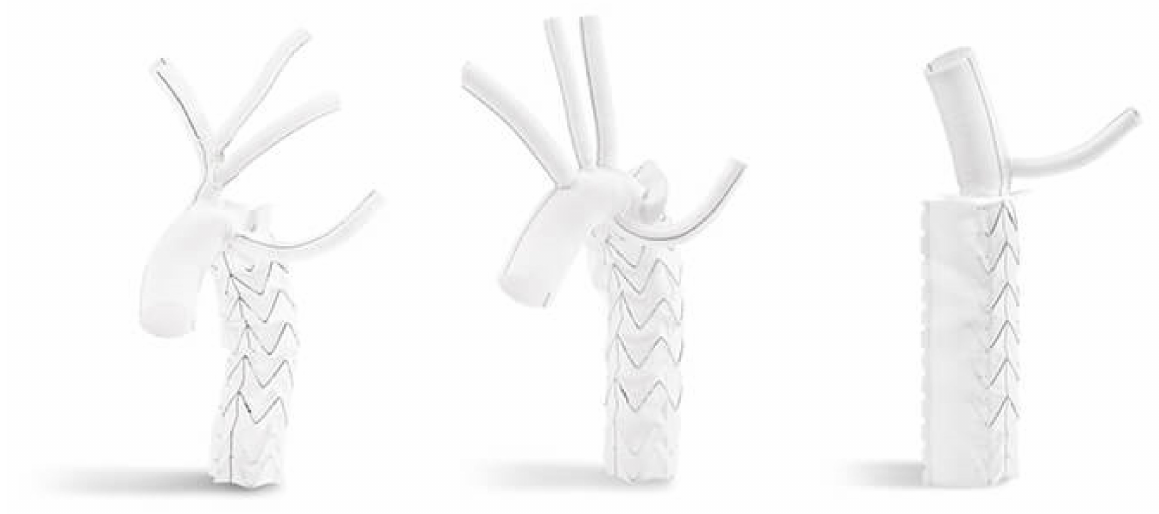
Figure 5. The Cryolife Jotec E-vita OPEN NEO hybrid stent graft system is composed by a proximal dacron prosthesis for the arch and a distal self-expandable stent graft with Z-nitinol stents for the descending thoracic aorta.